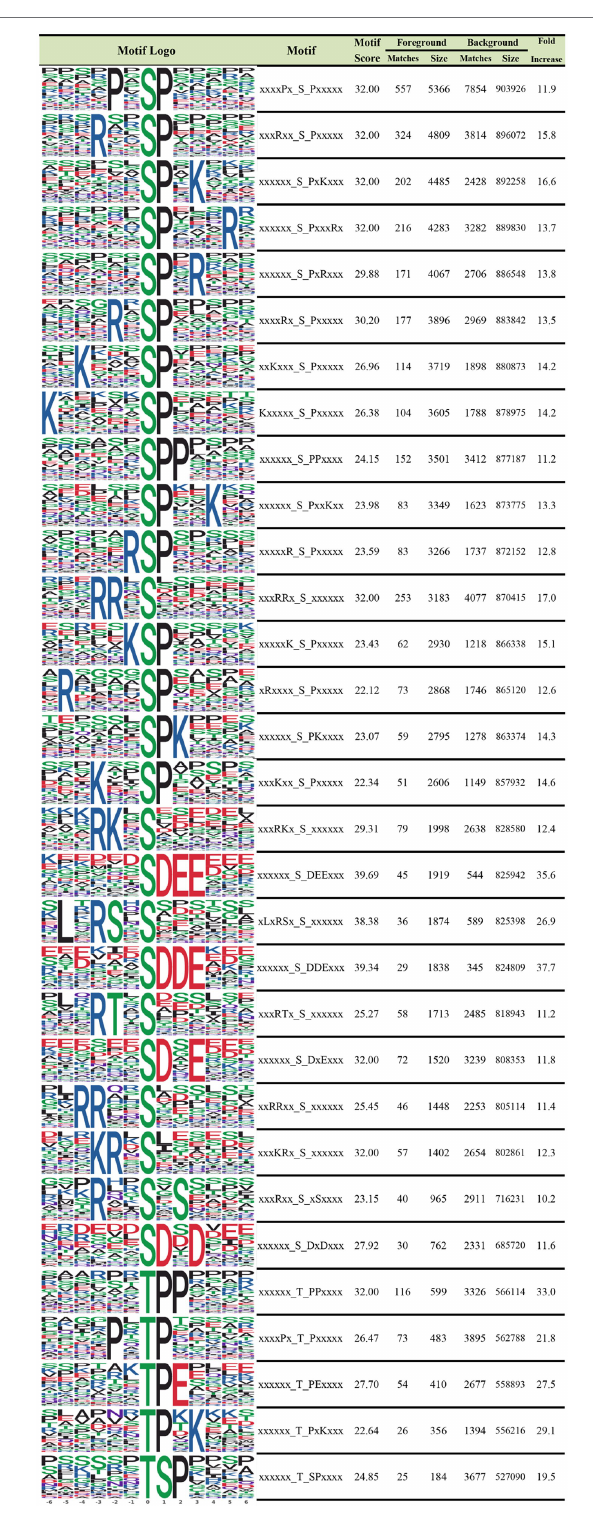
FIGURE 3 | Motif analysis of the identified phosphoproteins in IBRS-2 cells infected with SVA. The obtained phosphosites’ characteristics at serine and threonine residues and their enrichment statistics are shown, and serine and threonine motifs with a fold increase >10 are